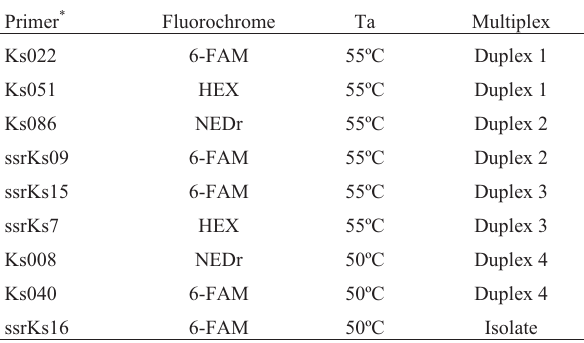
Table 1 - Primers used to amplify SSR markers in K. grandifoliola , with their respective fluorochromes, annealing temperature (Ta, °C) and multi-